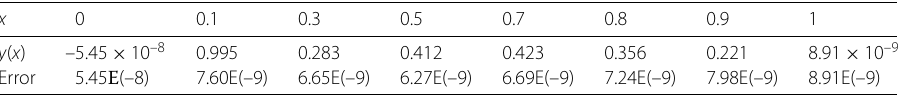
Table 6 For Example 7, showing the numerical solutions and the absolute errors obtained by the BSFM at different